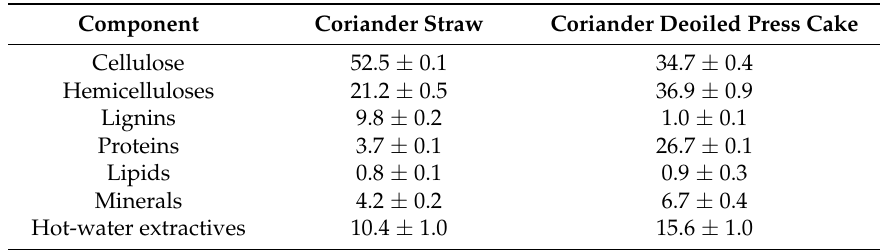
Table 1. Chemical composition of coriander straw and deoiled press cake (% of dry